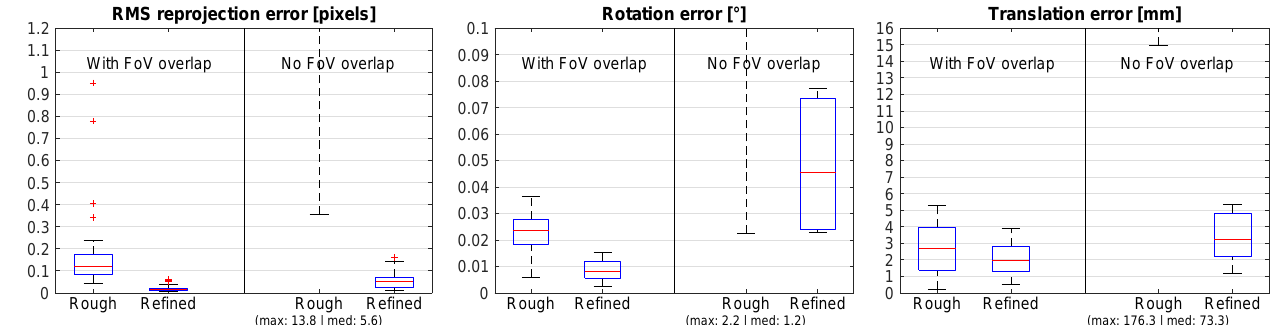
Figure 6. Comparison between scenes with and without overlap. Rough and Refined refer to the results before and after the refinement step. Missing maximum and median values are shown in parentheses.